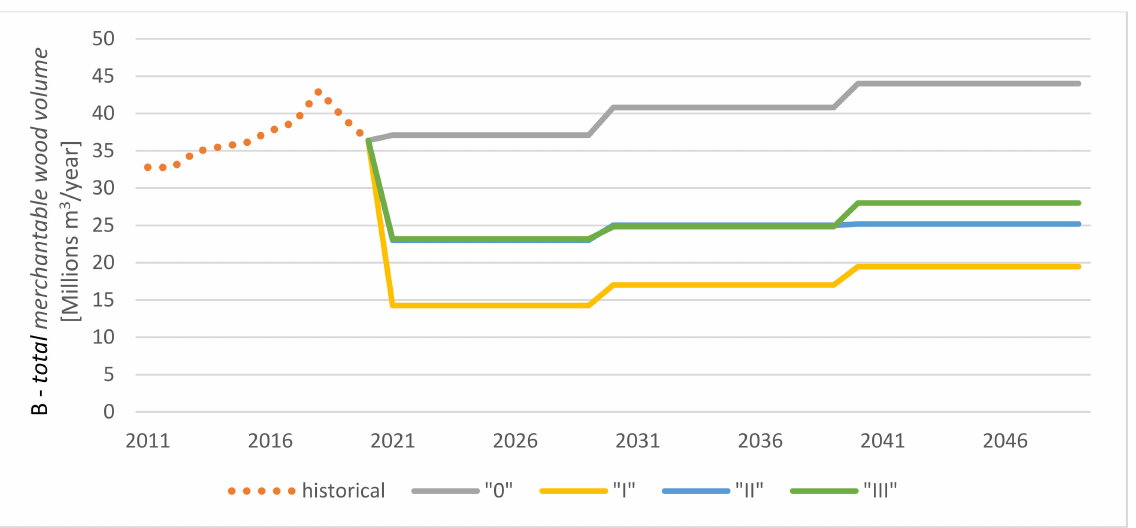
Figure 2. Change in the total harvested timber volume in the scenarios against the background of the historical total harvested timber volume.